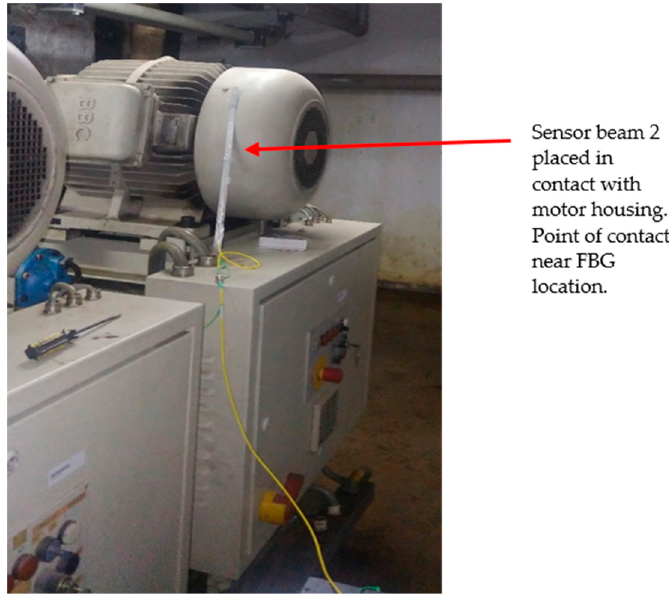
Figure 14. Sensor beam 2 used to detect vibrational frequencies of a motor, which was placed in contact with the motor housing. The contact area was near the location of the FBG.